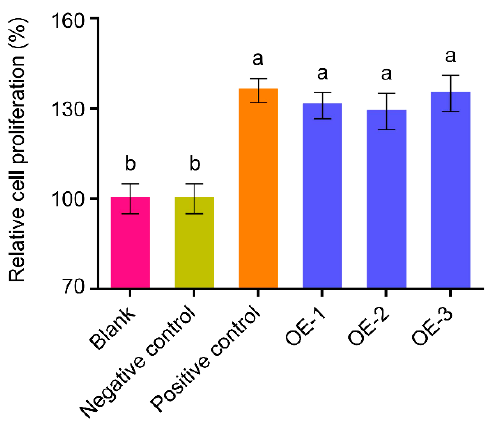
Figure 4. The hEGF protein purified in peanut hairy roots has biological activity. Biological activity of hEGF on human liver cells. Blank, the normal human liver cell HL-7702 cells; Negative control, the interception proteins from hairy roots infected with R1601 are supplemented with HL-7702 cells; Positive control, the hEGF peptide obtained from Sangon (Shanghai, China); OE-1, OE-2 and OE-3, the interception proteins from three independent hEGF transgenic peanut hairy root lines are each supplemented with HL-7702 cells. Error bars indicate SEM ( n = 3), p < 0.01. One-way ANOVA Duncan’s test is used for statistical analysis. Statistical differences are indicated by lowercase letters and different letters represent different significance. These experiments were repeated three times with similar results.